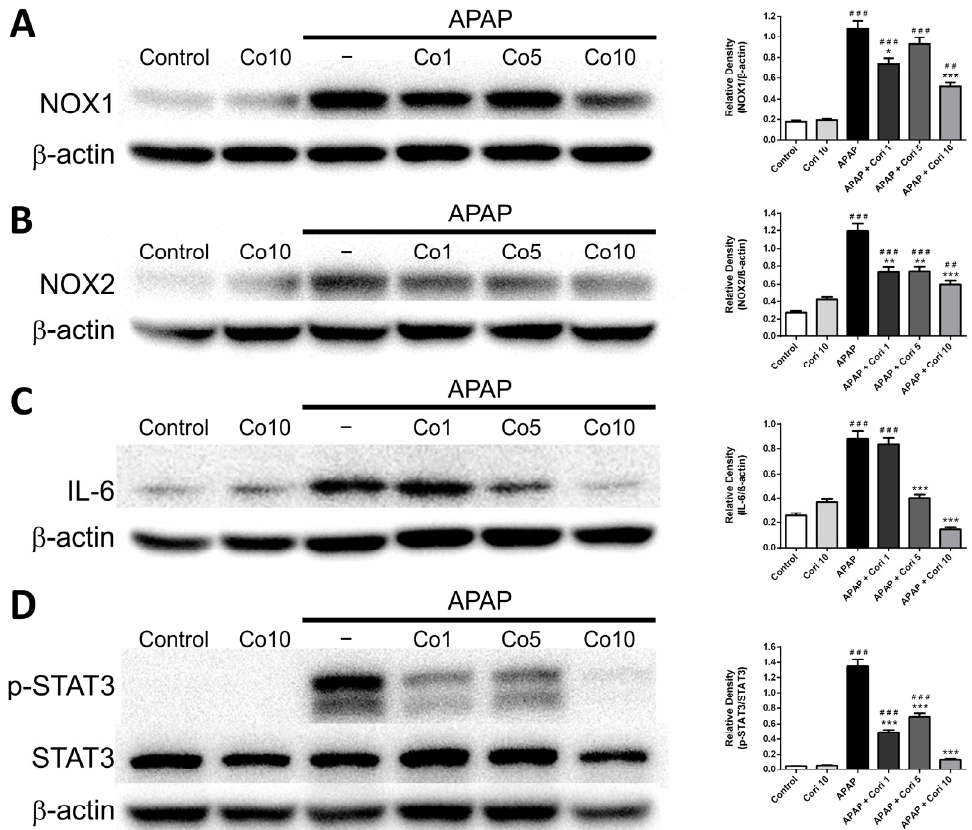
Figure 6. The effects of corilagin on NOX1 ( A ), NOX2 ( B ), IL-6 ( C ), and STAT3 ( D ) expression. Animals were injected with APAP (300 mg/kg) or equal volume of saline (control), and treated with corilagin (0, 1, 5, or 10 g/kg) after 30 min. ## p < 0.01, ### p < 0.005 vs. control group; * p < 0.05, ** p < 0.01, *** p < 0.005 vs. APAP group. Figures S1–S4 Uncropped Western blots.